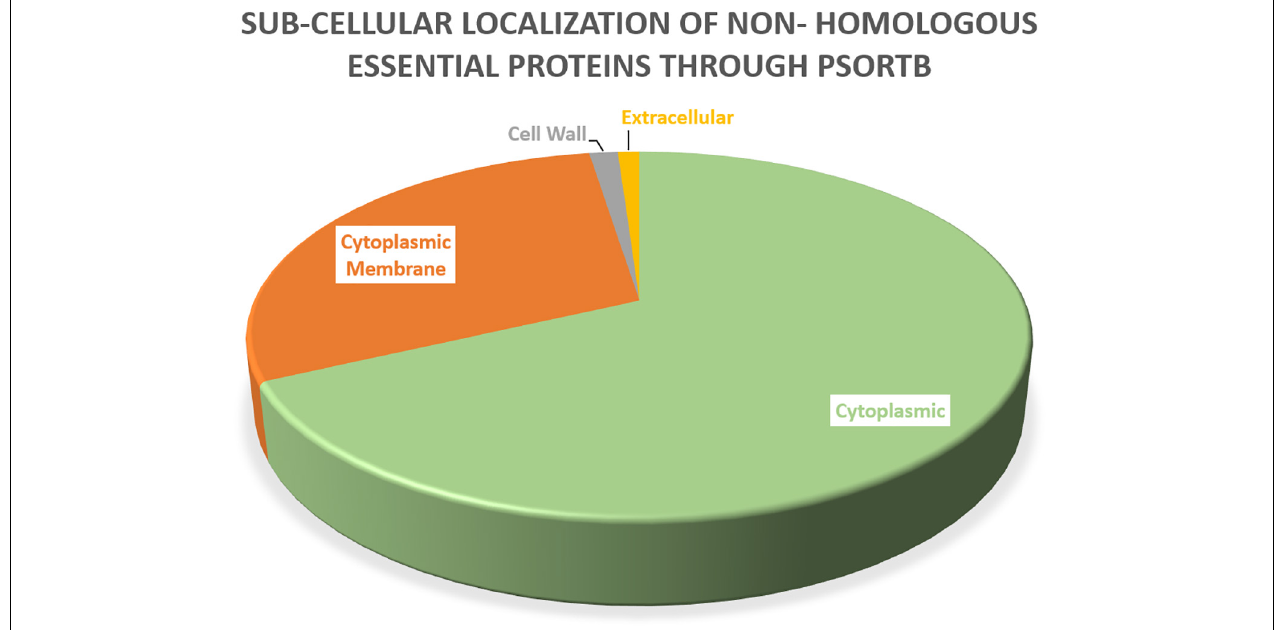
FIGURE 2 | Subcellular localization: PSORTb results showing the subcellular distribution of essential proteins occur in S. pneumoniae .